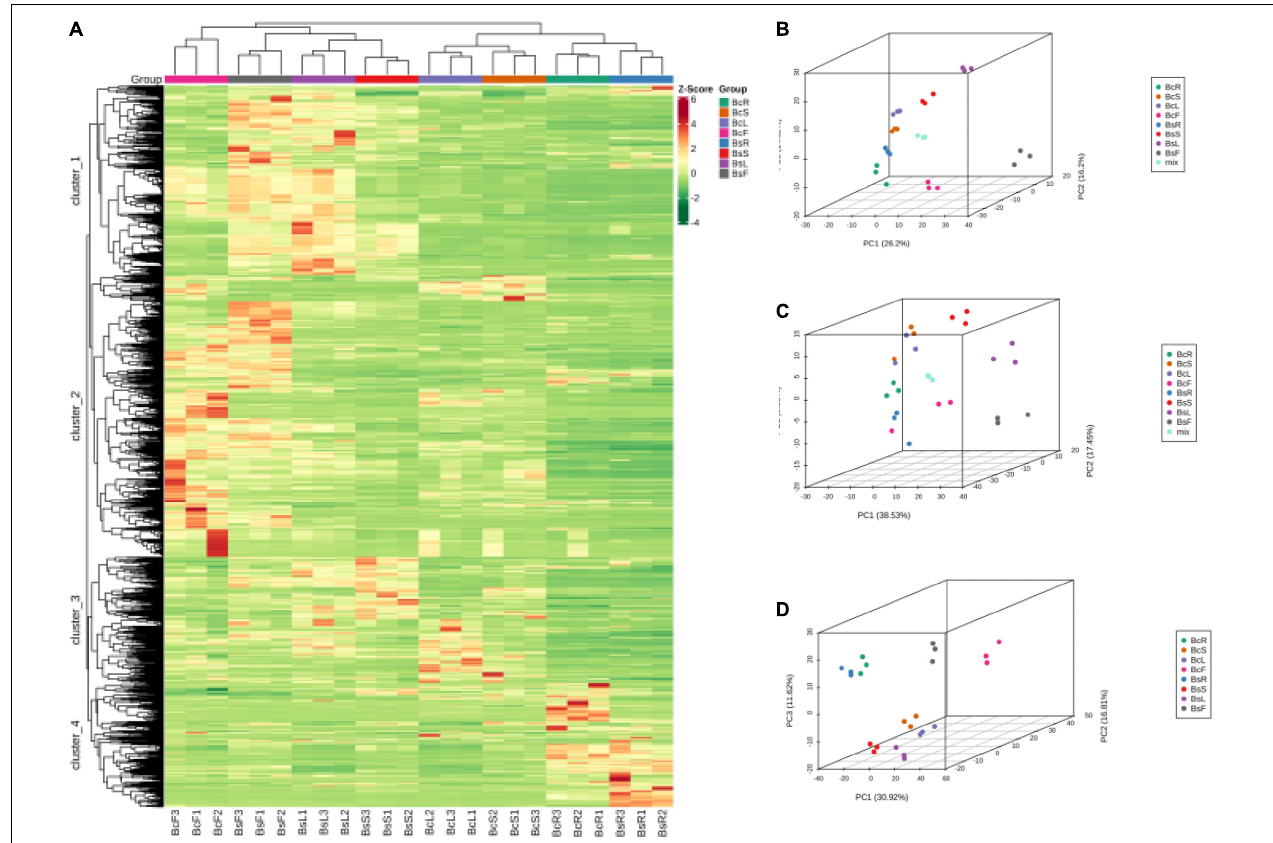
FIGURE 3 | Heat map of HCA and PCA of the relative differences in the metabolite profiles between different varieties and parts. The metabolites are divided into four clusters (A) , 3D PCA plot of LC-MS (B) , GC-MS (C) , and incorporated PCA plot (D)